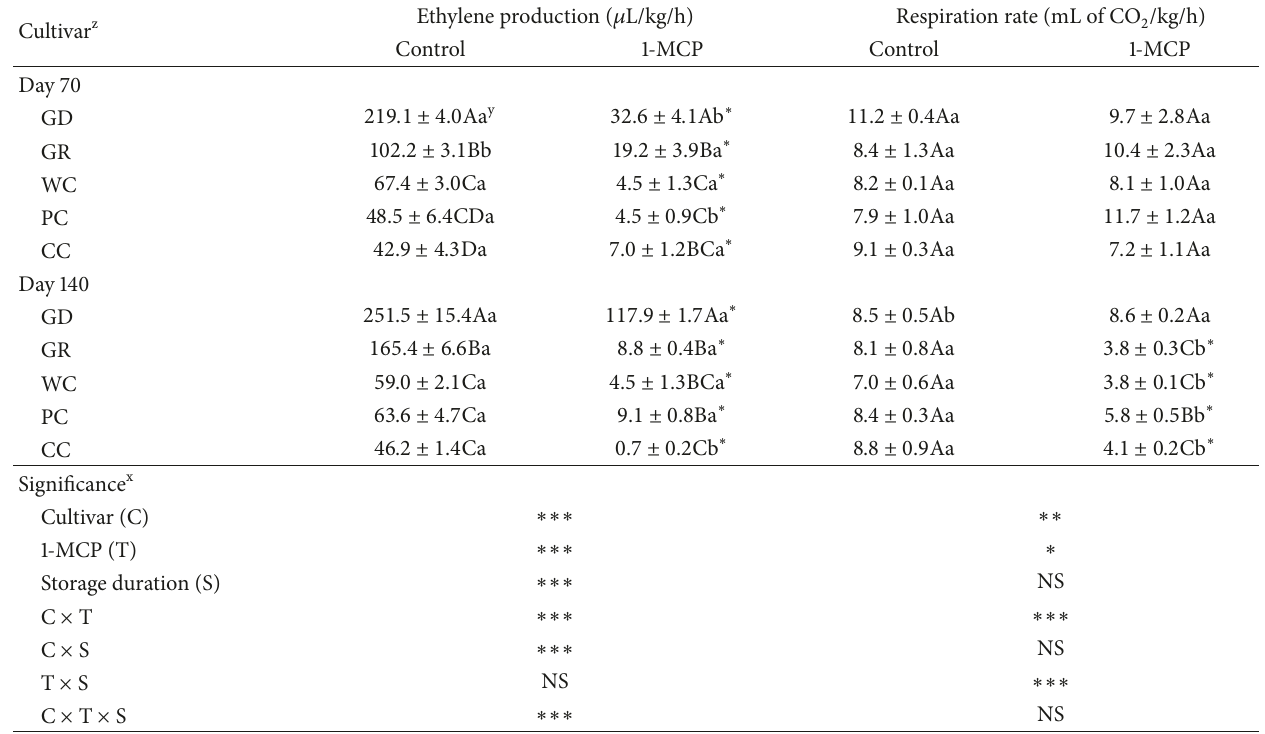
Table 2: Ethylene production and respiration rate of apple fruit at 70 or 140 days of storage at 0 ∘ C followed by 7 days at 20 ∘ C. Cultivar